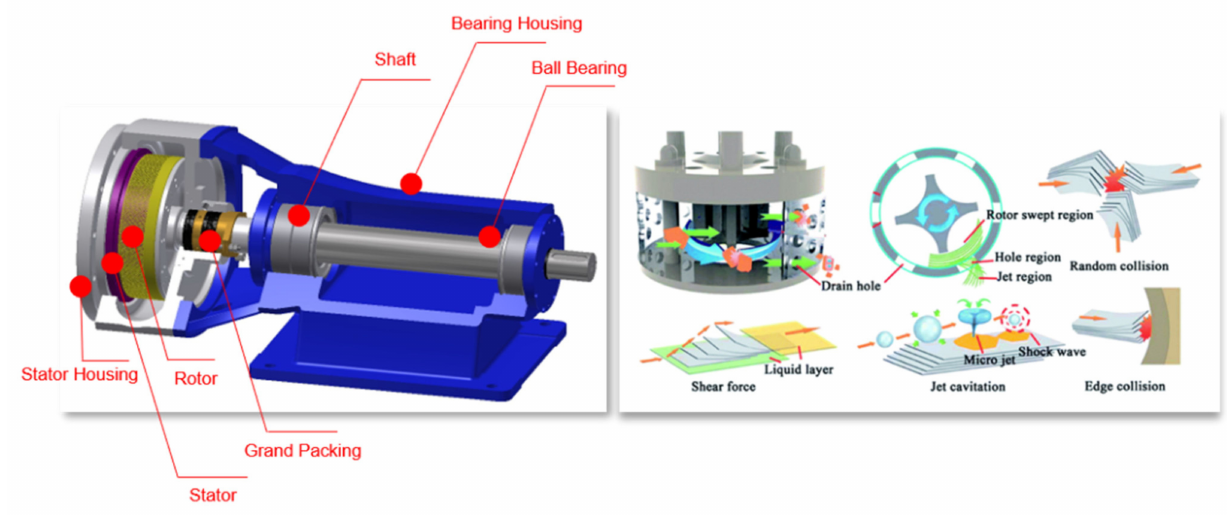
Figure 1. Schematic diagram of the working principle of grinding